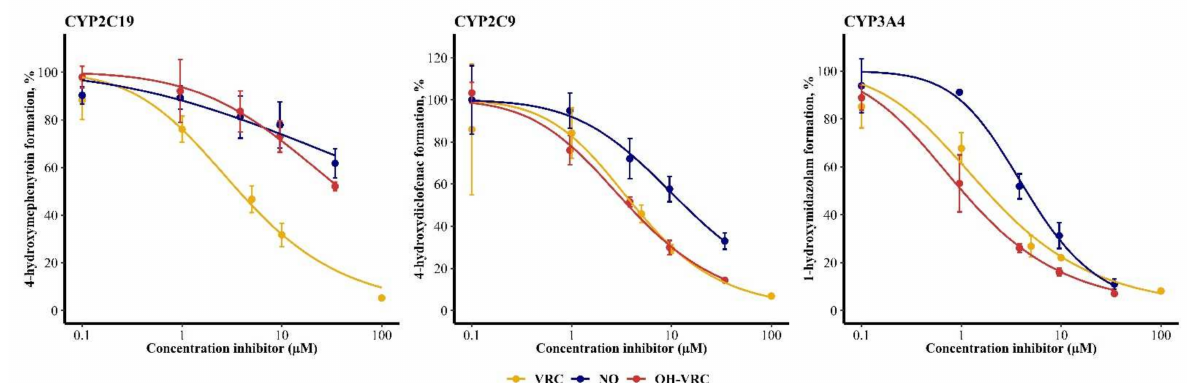
Figure 4. Inhibitory potential of voriconazole (VRC), voriconazole N -oxide (NO) and hydroxyvoriconazole (OH–VRC) on CYP2C19, CYP2C9 and CYP3A4 presented as the remaining activity of the respective marker reaction in function of the inhibitor concentration. Data points—mean activity ( n = 4); error bars—standard deviation of activity; solid lines—estimated relation between activity and inhibitor